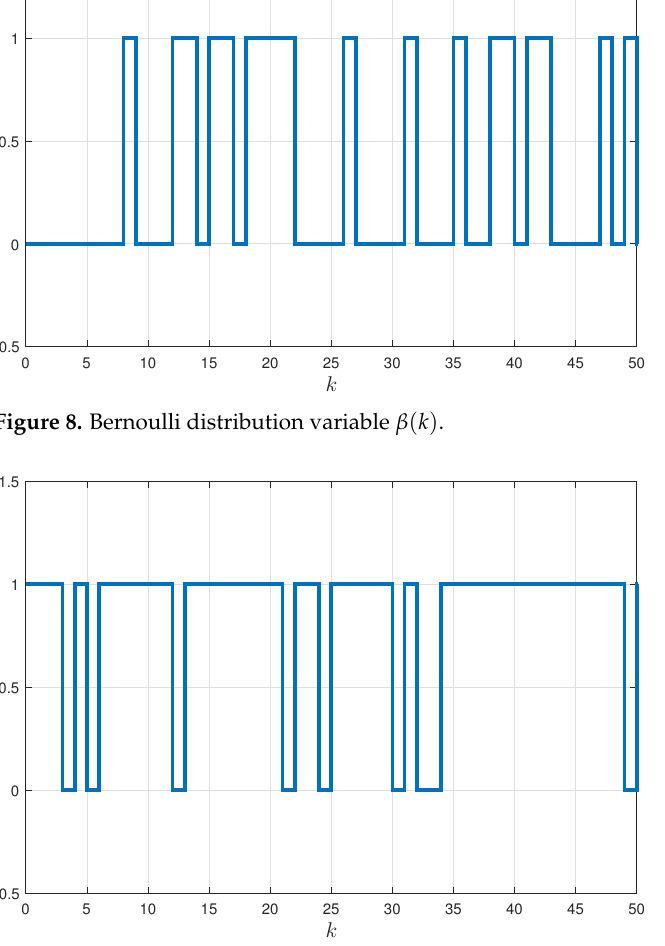
Figure 9. ‘Bernoulli distribution variable θ ( k )